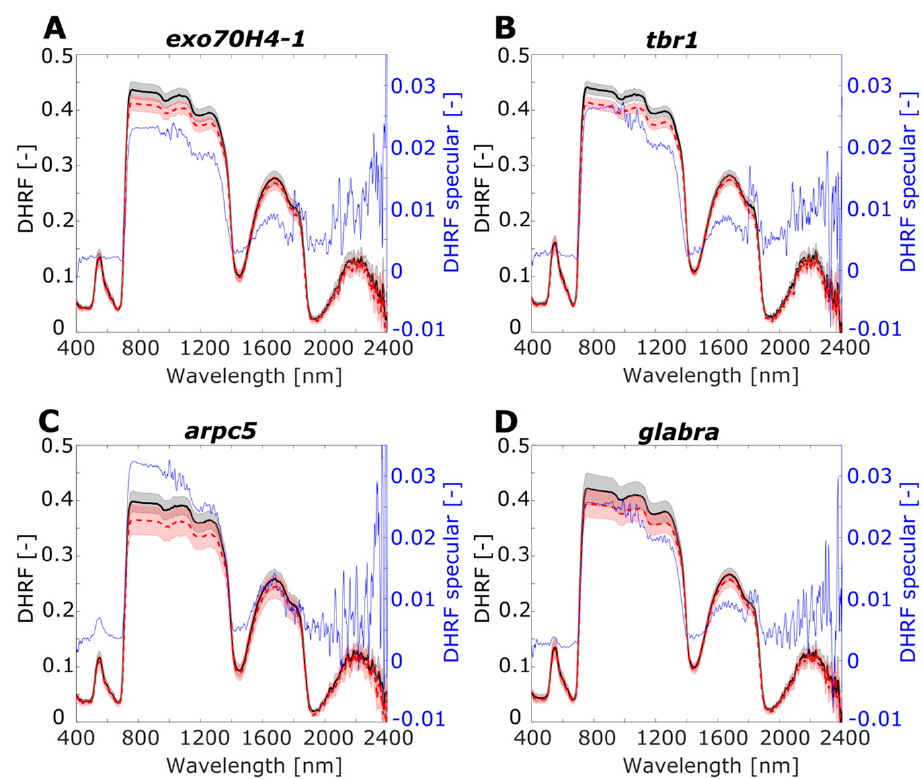
Figure 6. Leaf optical properties averaged for R TOT , R SR , and R SPEC for A. thaliana lineages: ( A ) exo70H4-1 , ( B ) tbr1 , ( C ) arpc5 , ( D ) glabra . Left y-axis shows directional–hemispherical reflectance factor (DHRF) of R TOT and R SR , and right y-axis corresponds to DHRF of specular component R SPEC . Grey and light red shadows of R TOT and for R SR curves display variance among the samples by standard deviation value. Black axes (left) correspond to DHRF of R TOT and R SR and blue axes (right) correspond to DHRF of R SPEC.